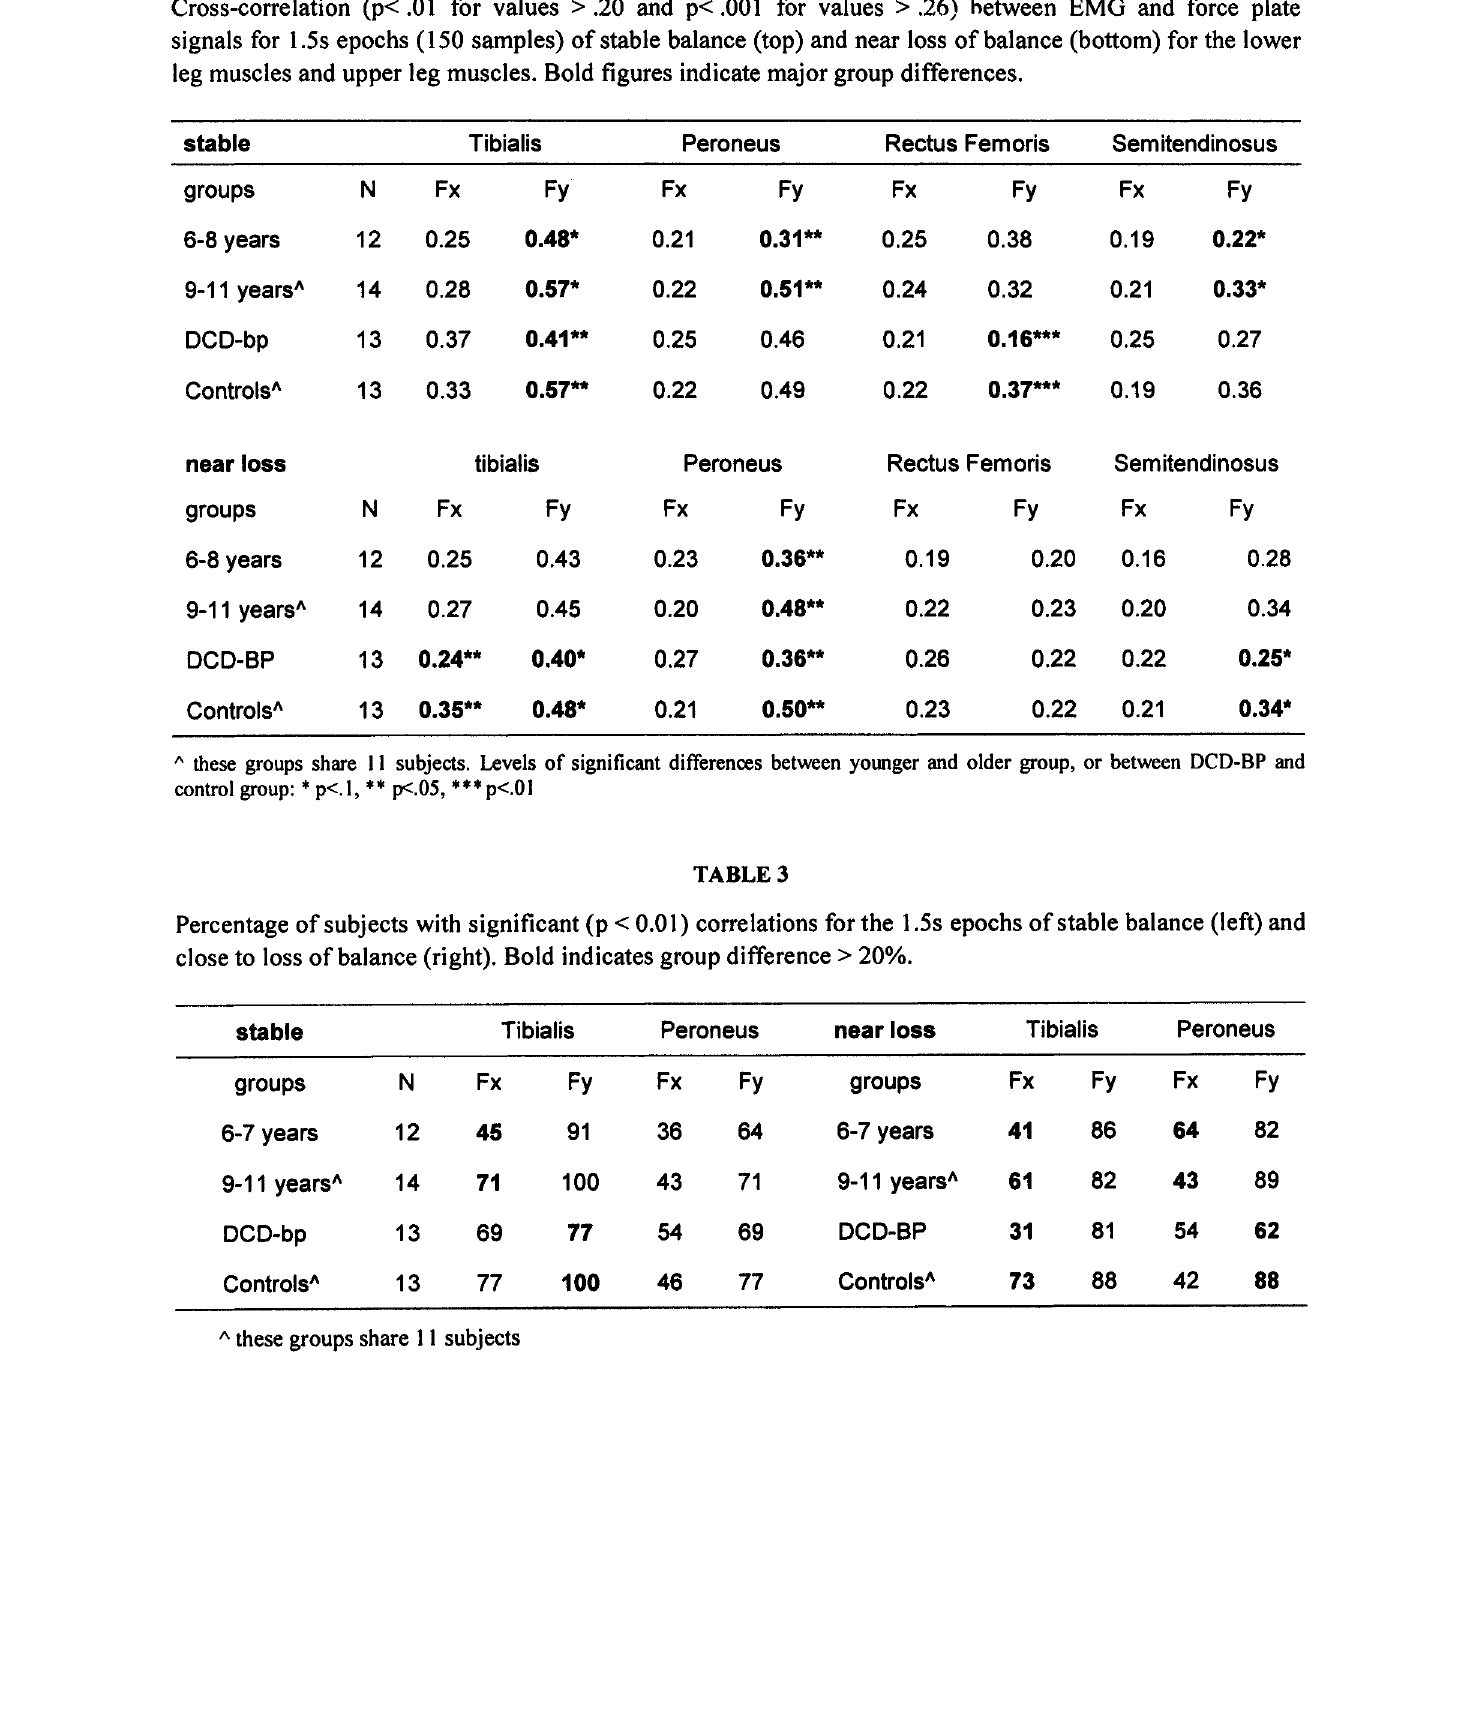
Cross-correlation (p< .01 for values > .20 and p< .001 for values > .26) between EMG and force plate signals for 1.5s epochs (150 samples) of stable balance (top) and near loss of balance (bottom) for the lower leg muscles and upper leg muscles. Bold figures indicate major group differences.